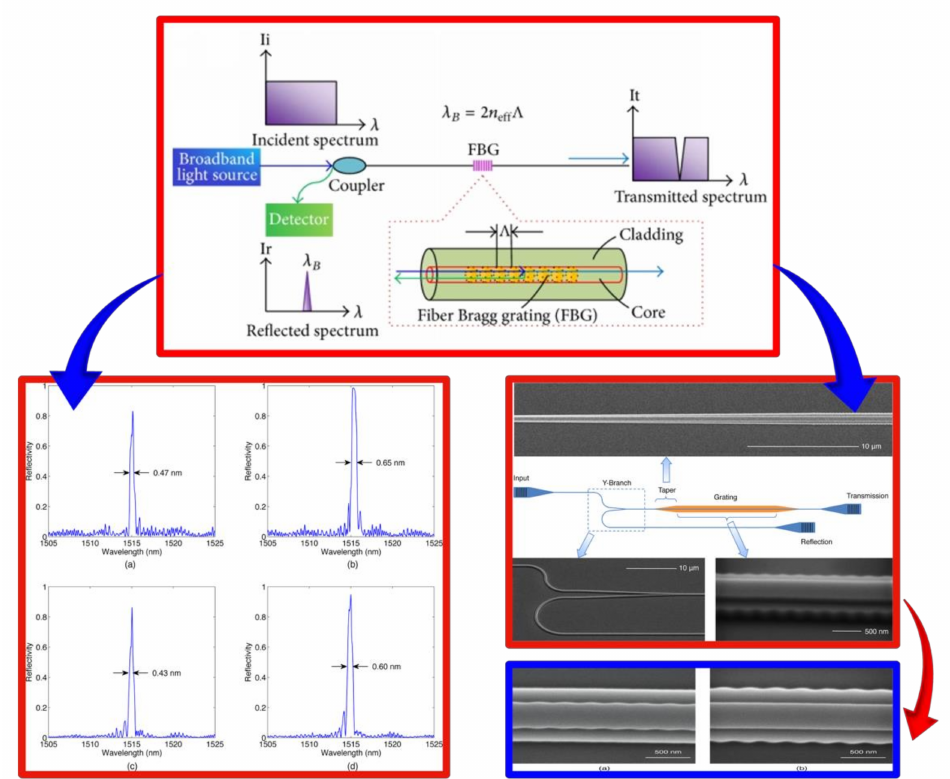
Figure 6. Layout of FBGs sensor. Left: Reflection spectra obtained using Bragg gratings on ridge waveguides ( a , b ) ridge grating, ( c , d ) slab grating.Adapted with permission from [39] Copyright 2015 © Royal Society of Chemistry. Right: The two configurations show similar performance but with a slight difference in bandwidth. SEM images of each of the FBG sensor components with emphasis on the top view ones of Bragg gratings ( a ) grating on ridge and ( b ) grating on slab